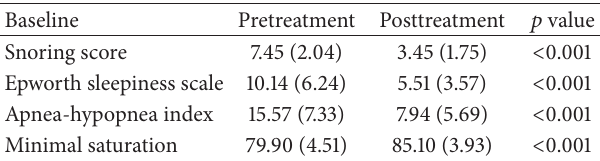
Table 1: Outcomes of radiofrequency ablation treatment in obstruc- tive sleep apnea